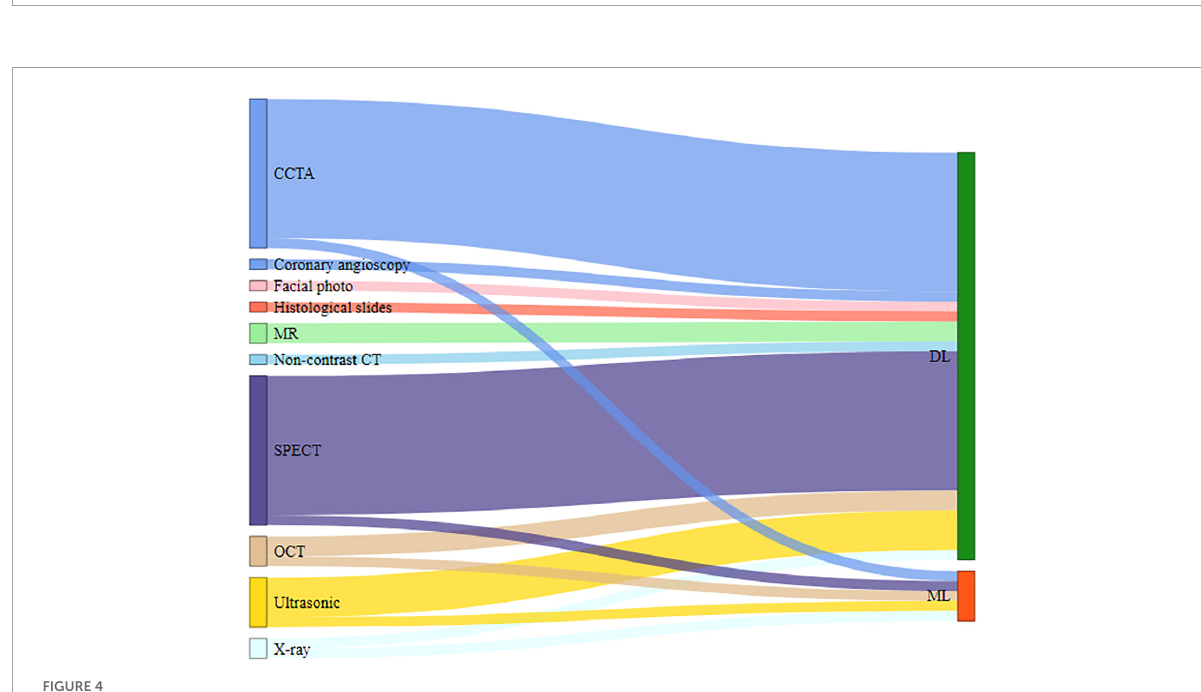
FIGURE4 Imaging types and AI